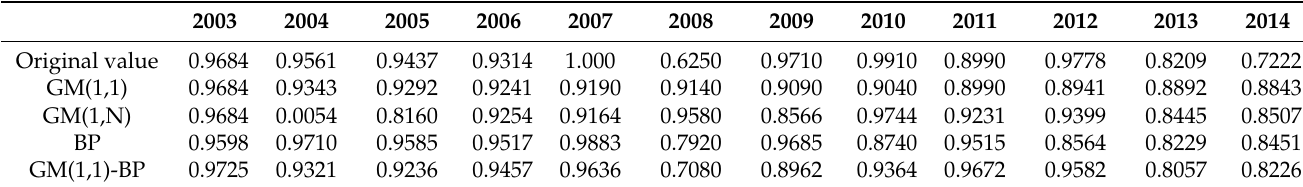
Table 1. Drug resistance prediction results for E. coli to sulfamethoxazole.